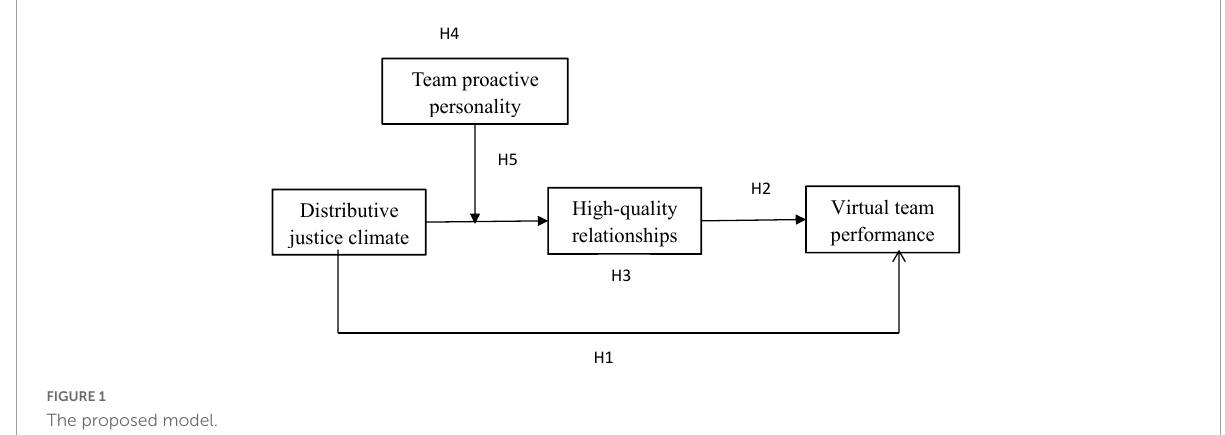
FIGURE1 The proposed